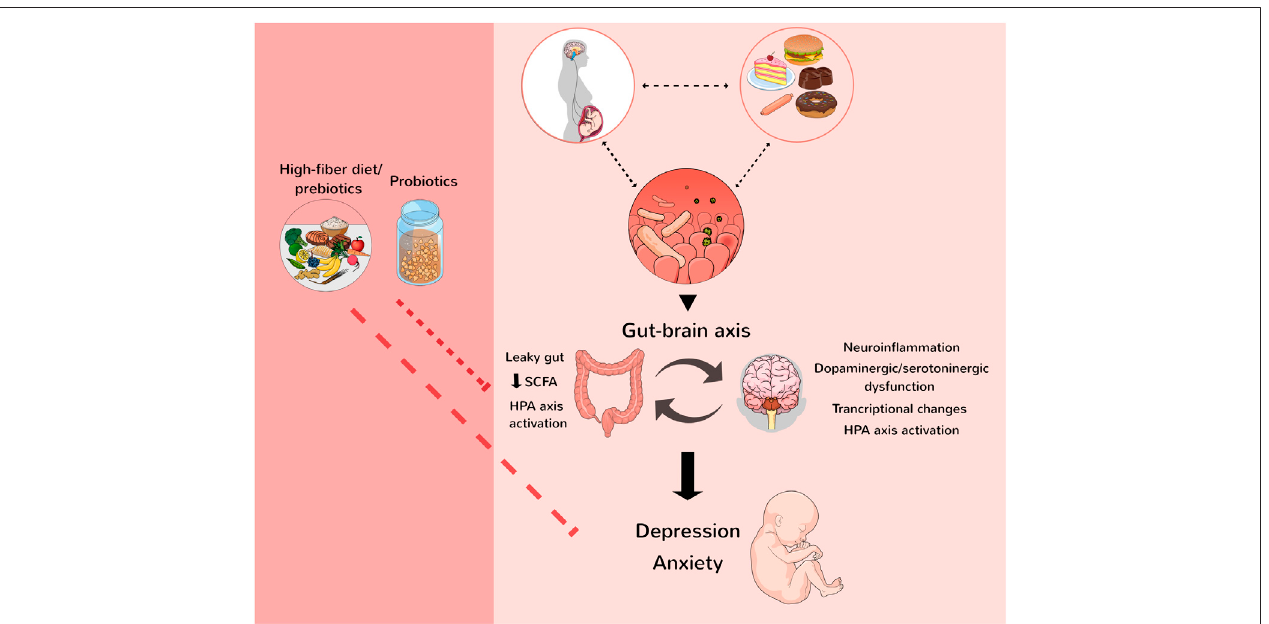
FIGURE1| Maternaldietcanaffecttheoffspring,increasingthechancesofmetabolicandneurodevelopmentaldiseases.Thegut-brainaxismodulatesanxietyand depression development since maternal microbiota in fl uence the offspring ’ s behaviour. Some mechanisms showed in the fi gure are proposed to in fl uence the development of neurological disorders such as psychiatric manifestations. The consumption of a high- fi ber diet, prebiotics, and probiotics is helpful to modulate the offspring ’ s microbiome and, thus, can diminish the risk of mental illnesses. HPA, hypothalamus-pituitary-adrenal; SCFA, short-chain fatty acids. Figure created by the authors with the assistance from Mind the Graph